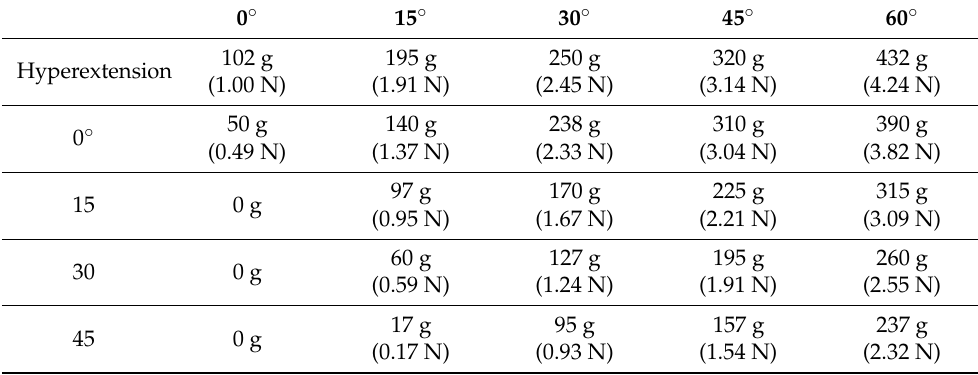
Table 2. Mean Forces of different ETDNO made with tubes at different angled positions. We considered the forces in bold to be within the therapeutic